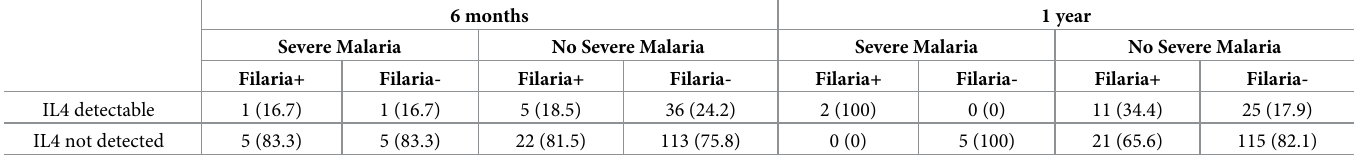
Table 3. Presence of detectable IL4 by severe malaria diagnosis and filarial serology status, n(%).